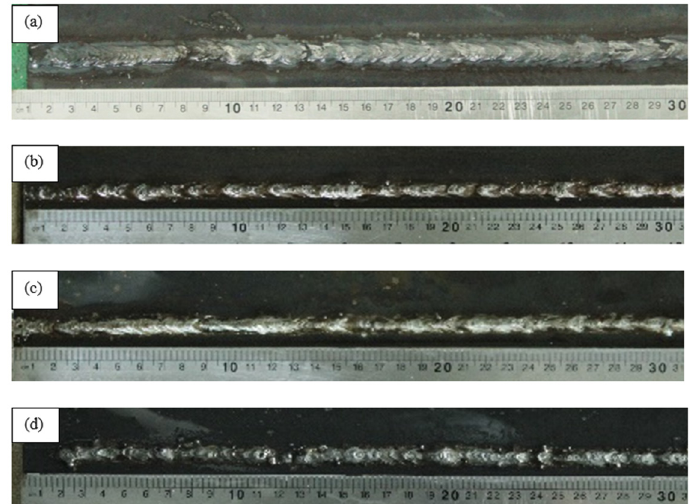
Figure 11. The welding results in ( a ) land-based welding, ( b ) underwater welding without flow, ( c ) underwater welding with the non-uniform flow with a baffle plate, and ( d ) underwater welding with the non-uniform flow without a baffle plate.